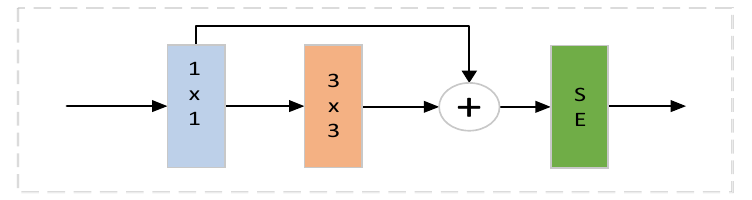
Figure 7. Illustration of the feature extraction module.